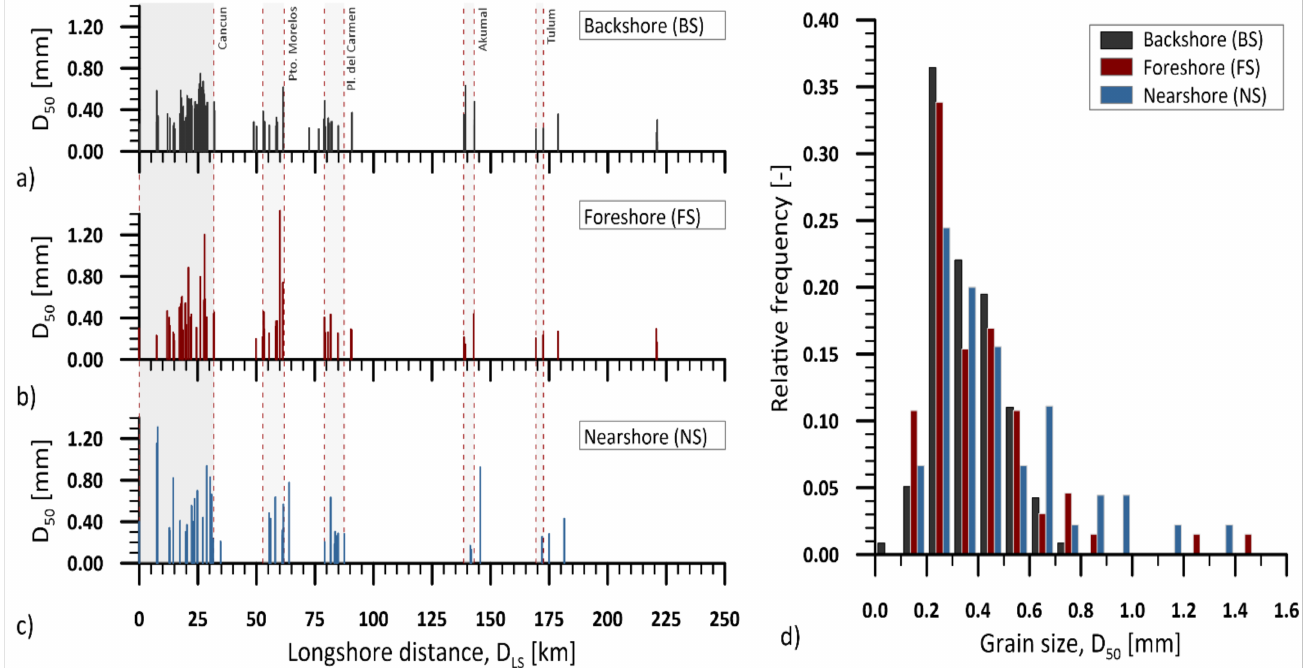
Figure 3. Grain size variations for the different beach profile sections: ( a ) BS, ( b ) FS and ( c ) NS. The zero-reference point D LS is at 21.24112 ◦ N, 86.80213 ◦ W, with DLS values increasing parallel to the coast and in a southerly direction. ( d ) Histogram for the grain size distribution for the different parts of the profiles for all the sample